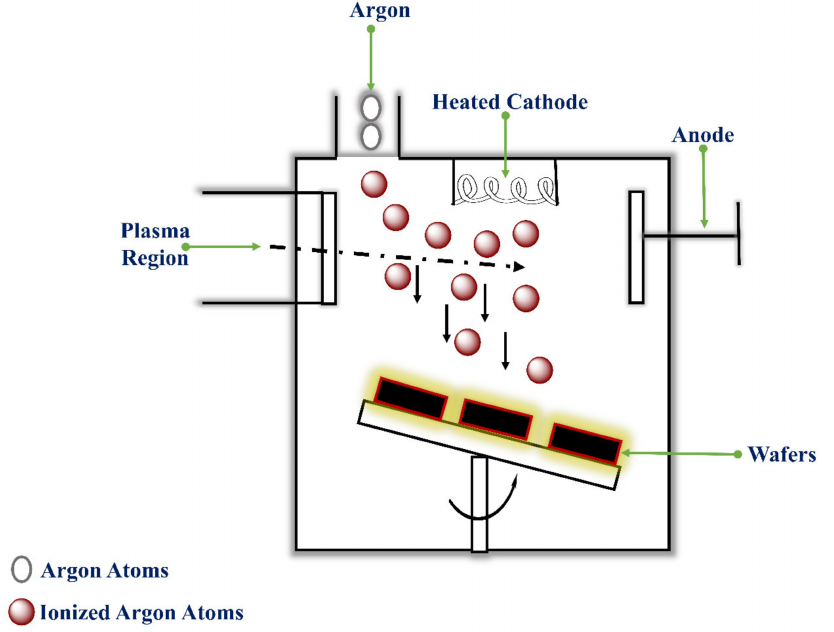
Figure 13. Representation of the ion beam etching process methods. Ar gas introduced in the vacuum chamber was ionized by bombarding with electrons. These ions are then directed onto the wafer, where they eliminate material by physical bombardment [189]. (Reprinted from Ref.